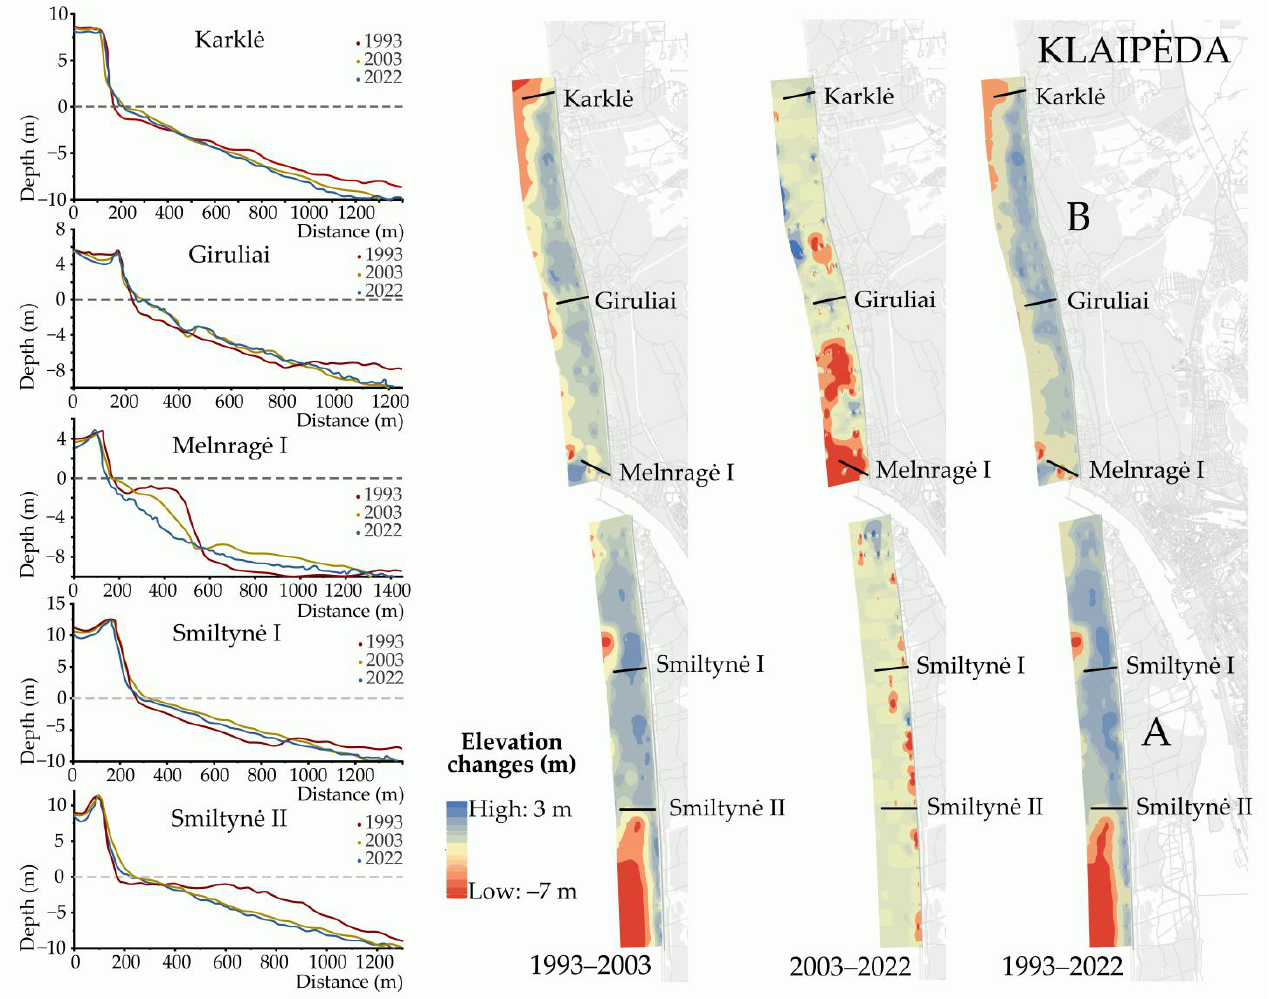
Figure 4. Elevation changes of the coastal zone on the Curonian Spit ( A ) and the mainland ( B ) coasts.